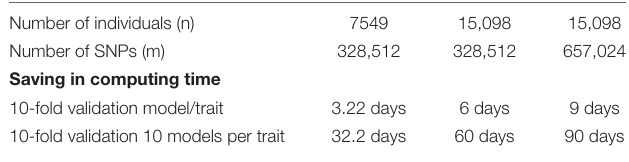
TABLE 3 | Approximate saving of computing time of GVCHAP due to the two-step strategy or multi-node processing (MNP) for a 10-fold validation study relative to the use of a single node of the Mesabi supercomputer without the two-step strategy of MNP. Number of individuals